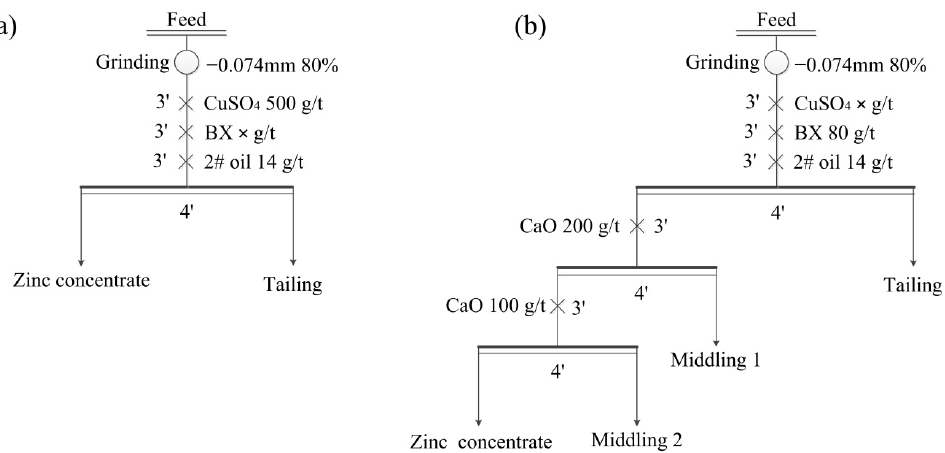
Figure 6. Experimental flow charts for the effects of BX ( a ) and CuSO 4 ( b ) dosages on zinc flotation.